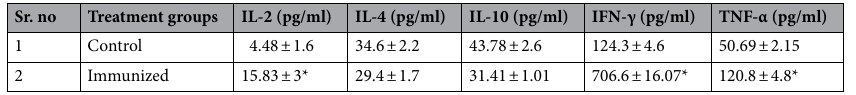
Table 1. Cytokines expression levels in different animal groups. Significant difference (*P < 0.05).